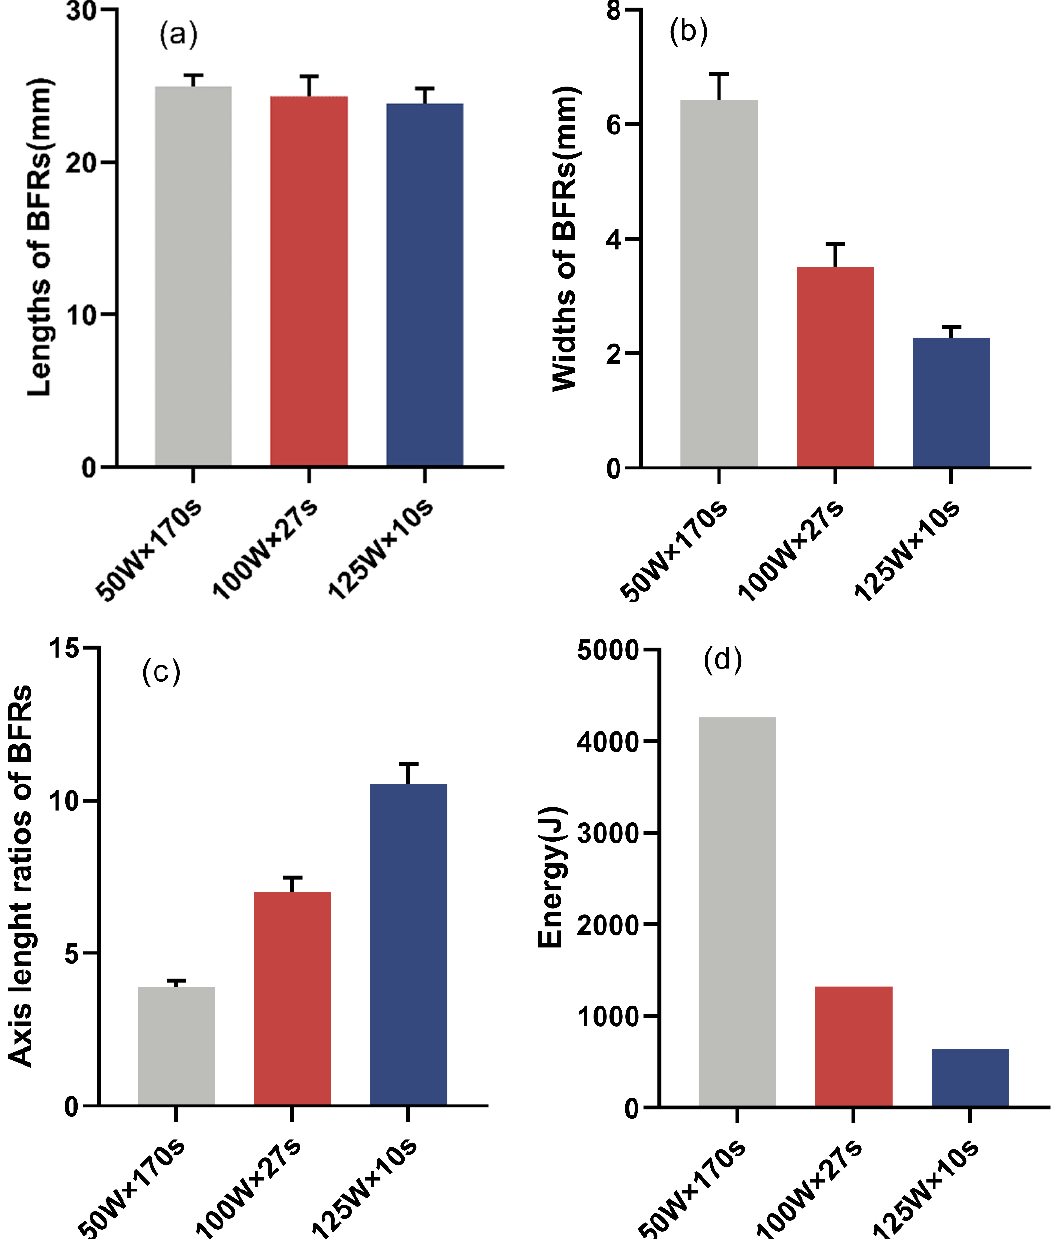
Figure 11. ( a ) Lengths ( b ) widths ( c ) axis length ratios of the BFRs, and ( d ) energy after ultrasonication with different combinations of acoustic power and time in bovine liver experiment.